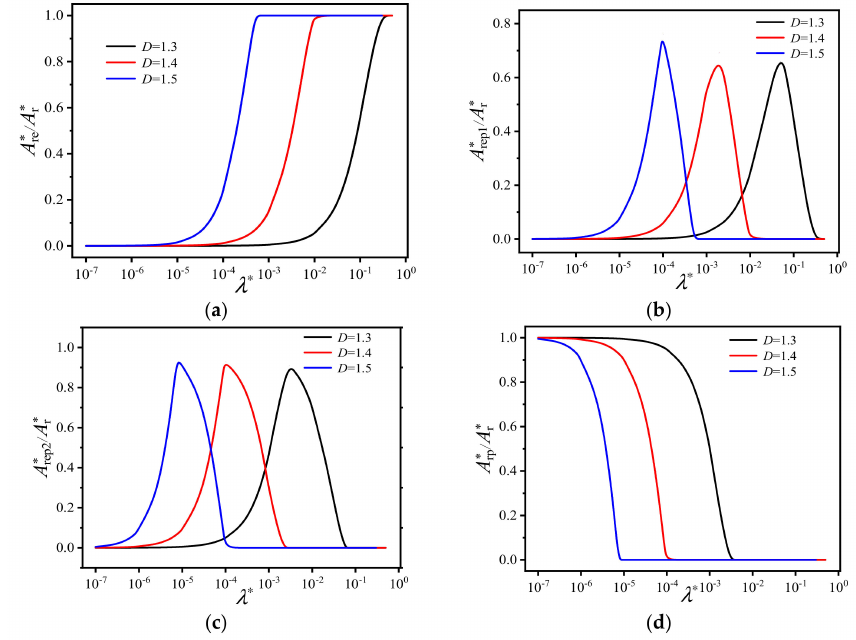
Figure 8. Influence of surface fractal dimension on multilength contact characteristics. ( a ) Proportion of elastic contact area versus λ *. ( b ) Proportion of elastoplastic contact area in the first stage versus λ *. ( c ) Proportion of elastoplastic contact area in the second stage versus λ *. ( d ) Proportion of plastic contact area versus λ